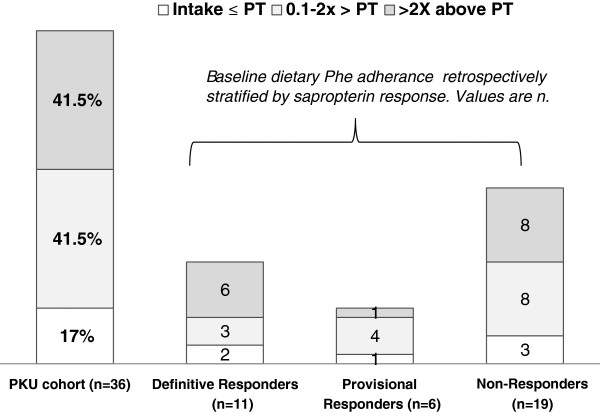
Baseline dietary Phe compliance of patients with PKU. ‡Dietary Phe compliance defined as patient-reported Phe intake in excess of Phe tolerance (PT) (mg/day). One patient with undetermined baseline Phe tolerance omitted from figure.